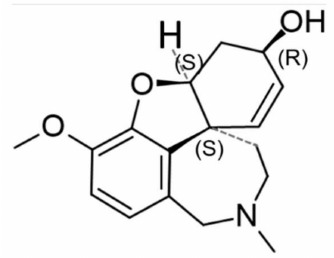
Figure 3. Chemical structure of galantamine.